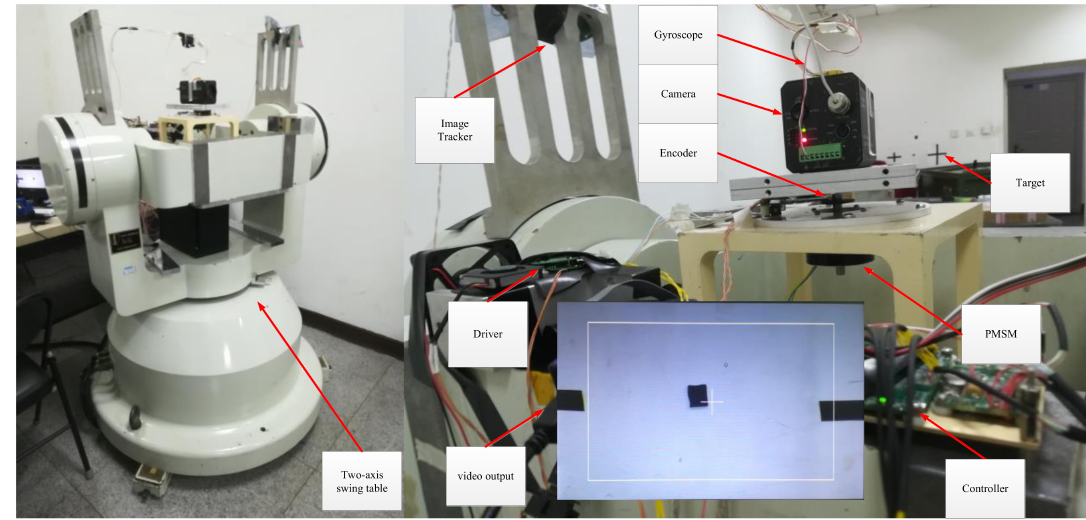
Figure 8. Photograph of the experimental